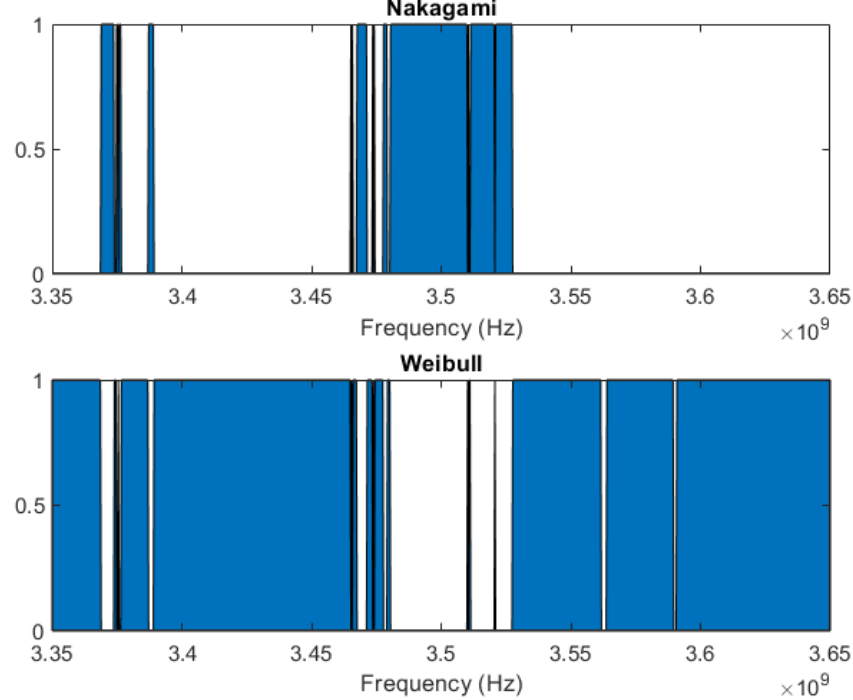
Figure 7. Best-fitted distributions as a function of frequency, at corridor LoS in the 3 GHz band.